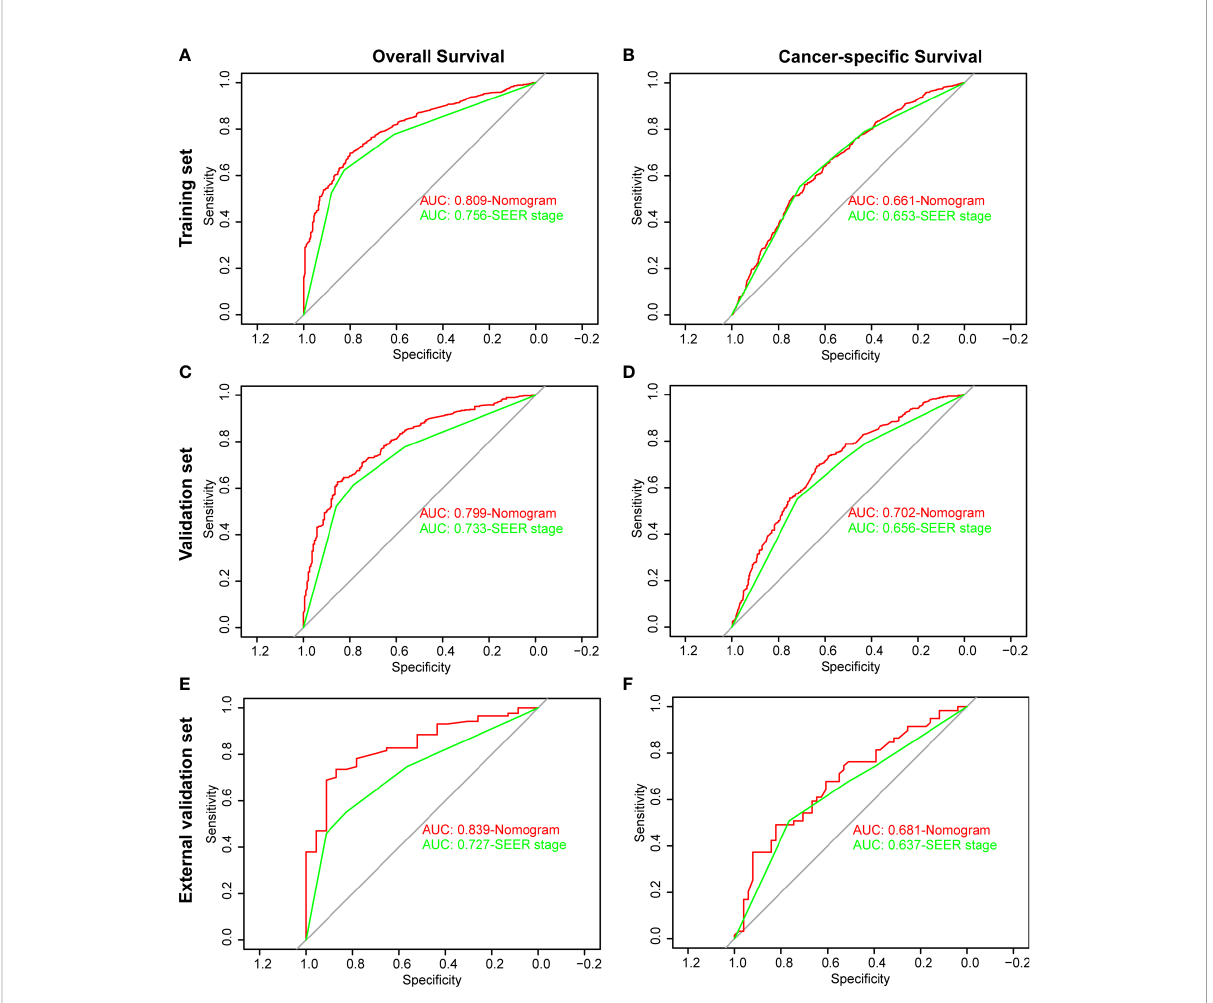
FIGURE 3 Receiver operating characteristic (ROC) analysis based on nomograms and SEER stage. (A) The ROC analysis of OS in the training set. (B) The ROC analysis of CSS in the training set. (C) The ROC analysis of OS in the validation set. (D) The ROC analysis of CSS in the validation set. (E) The ROC analysis of OS in the external validation set. (F) The ROC analysis of CSS in the external validation set.